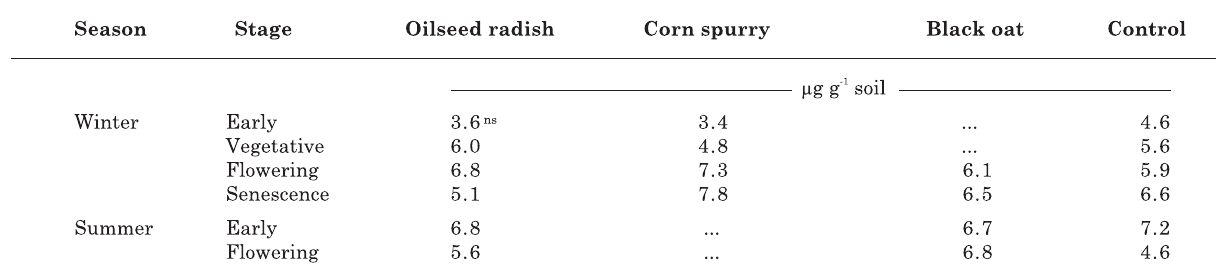
Table 2. Microbial biomass phosphorus in sandy soil under plant rotation systems during the first growing season of mycorrhizal (black oat) or non-mycorrhizal (oilseed radish and corn spurry) cover crops or with resident vegetation (control) in winter, followed by mycorrhizal crops in summer (pearl millet and